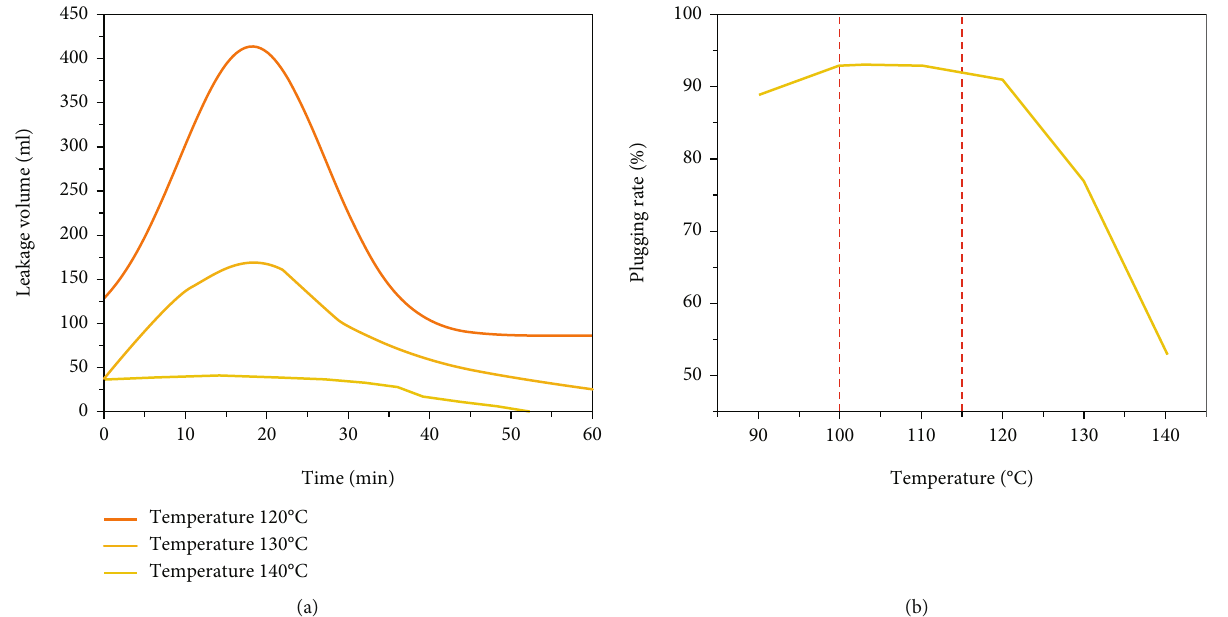
Figure 20: (a) The change in leakage over time at di ff erent temperatures. (b) The plugging rate of the plugging agent at di ff erent